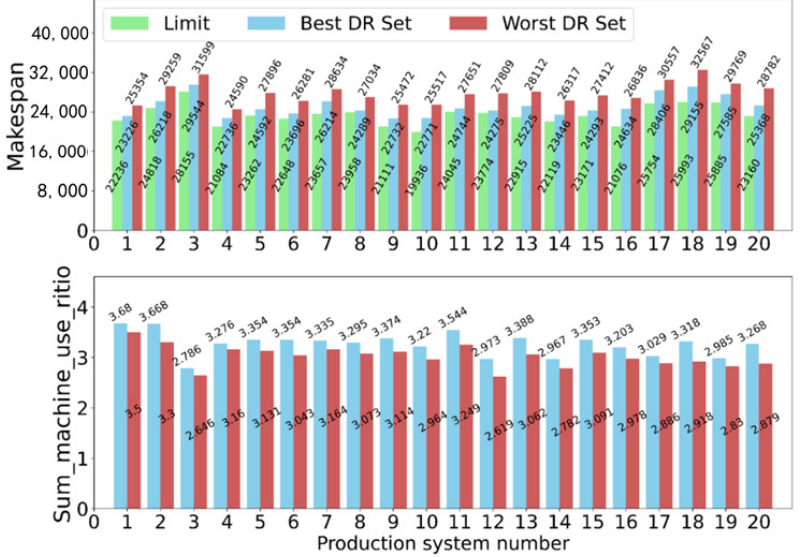
Figure 9. High job heterogeneity and a low manufacturing system load rate.